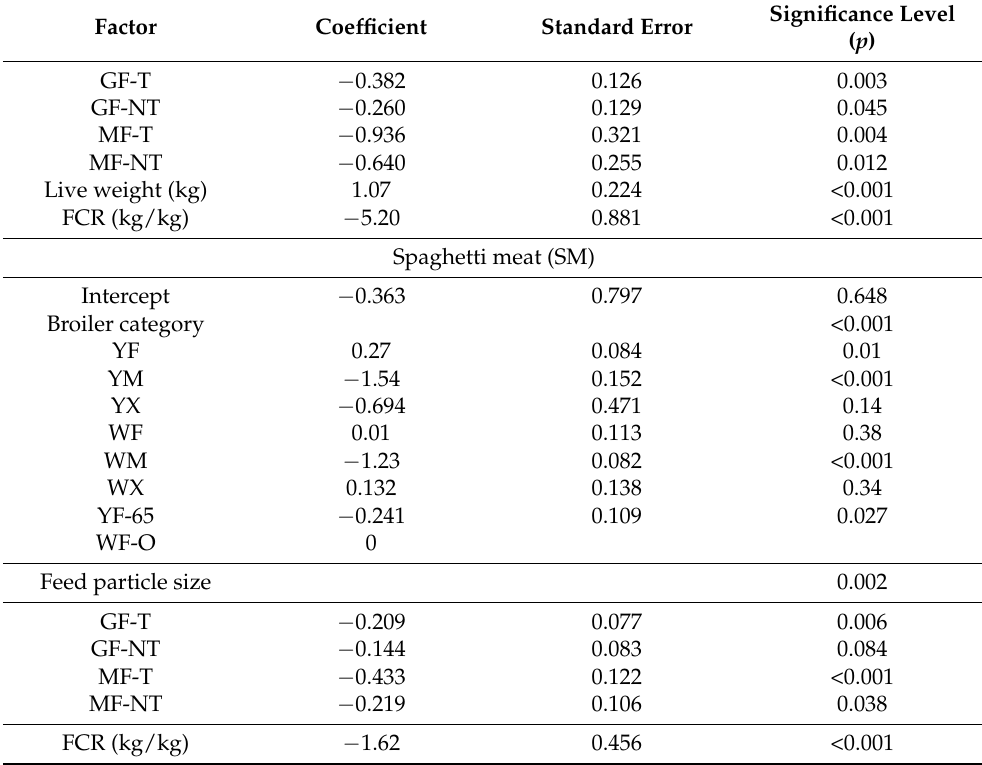
Table 2. Cont. Factor